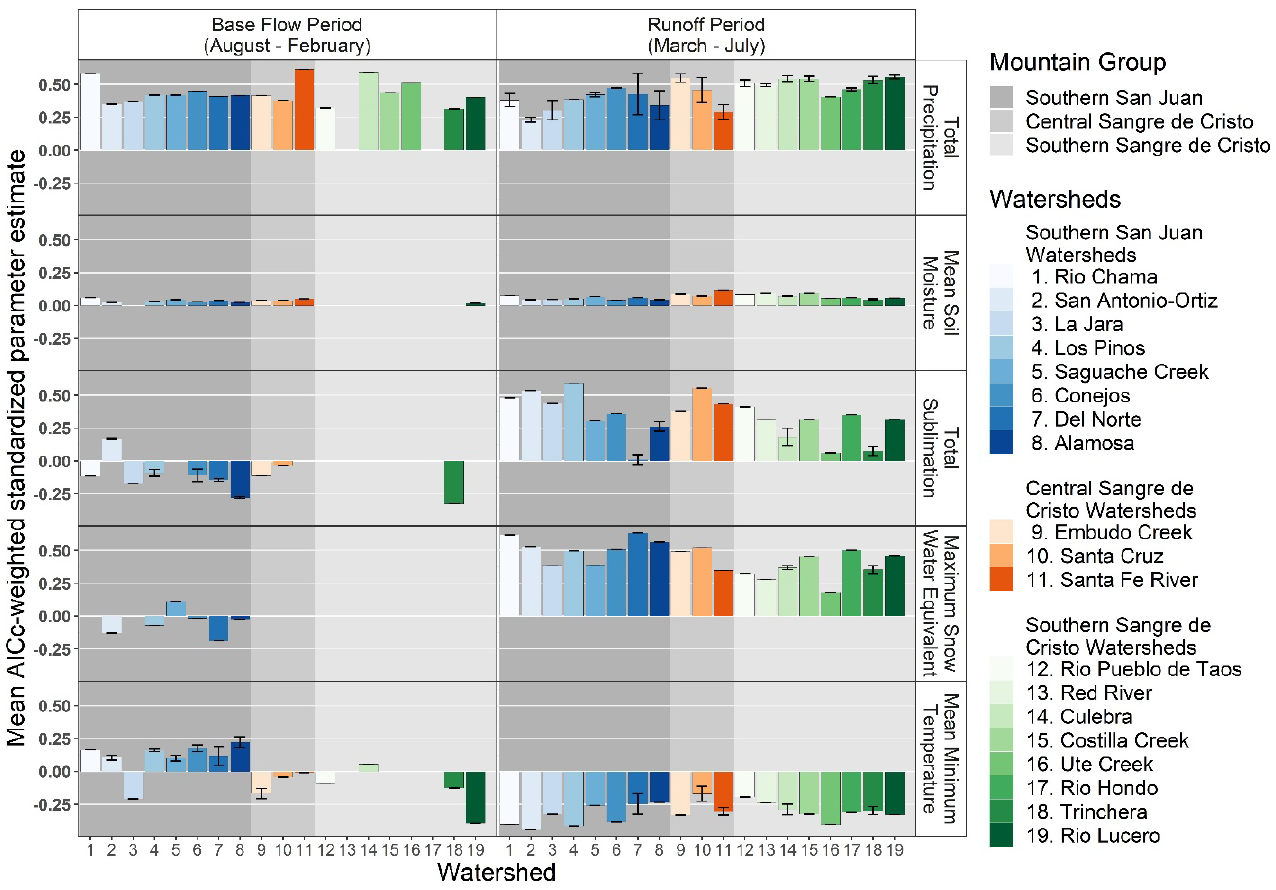
Figure 10. Overall average of estimation of parameter by period, with AICc-weighted standardized parameter estimates.